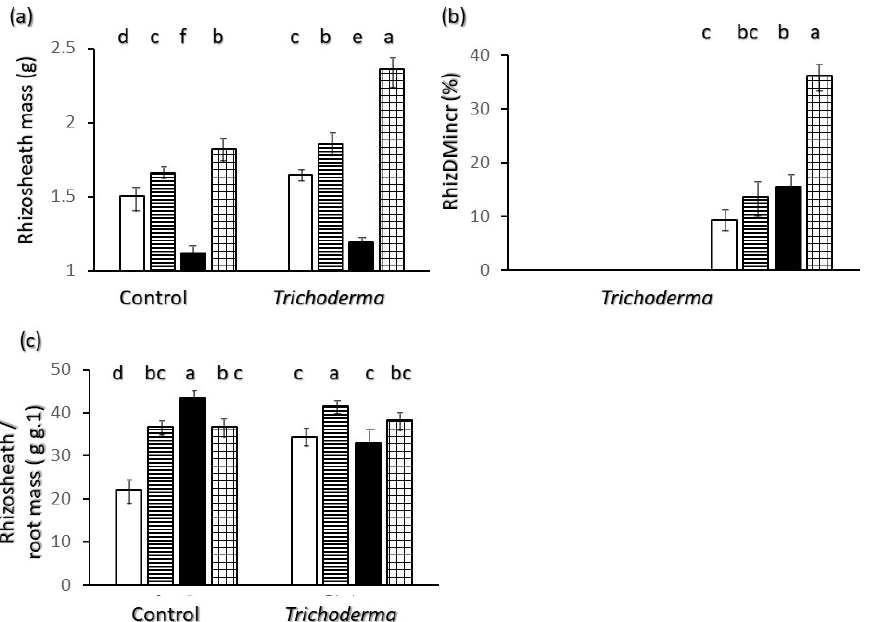
Figure 7. Rhizosheath mass data and indices. Interaction of wheat variety x Trichoderma harzianum T-22 inoculation on ( a ) rhizosheath mass; ( c ) rhizosheath/root mass ratio. Main effect of wheat variety on rizosheath percent weight gain upon inoculation RhizDMIncr ( b ). Color code of bars: white = Ciclope; horizontal stripes = Creso; black = Saragolle; grid = Simeto. Vertical segments on each bar indicate standard deviation n = 3. Different letters on each bar designate significantly different values for p < 0.05 at the Tukey’s post hoc mean separation